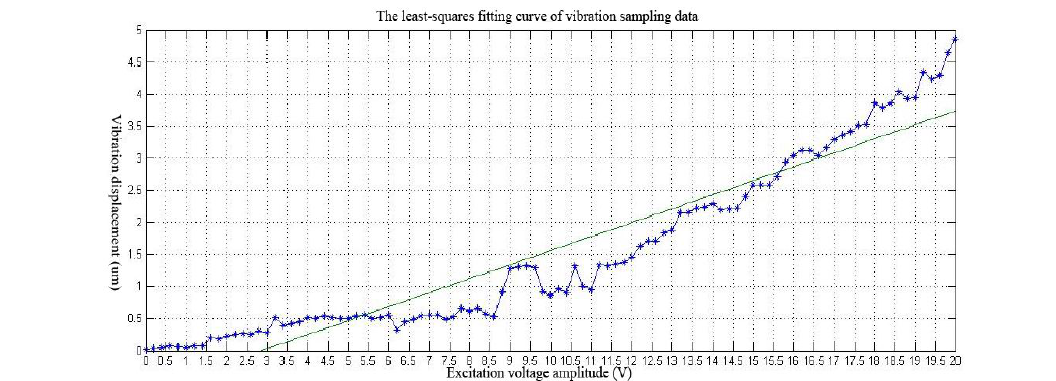
Fig.6 linear least squares estimate between vibration amplitude and input